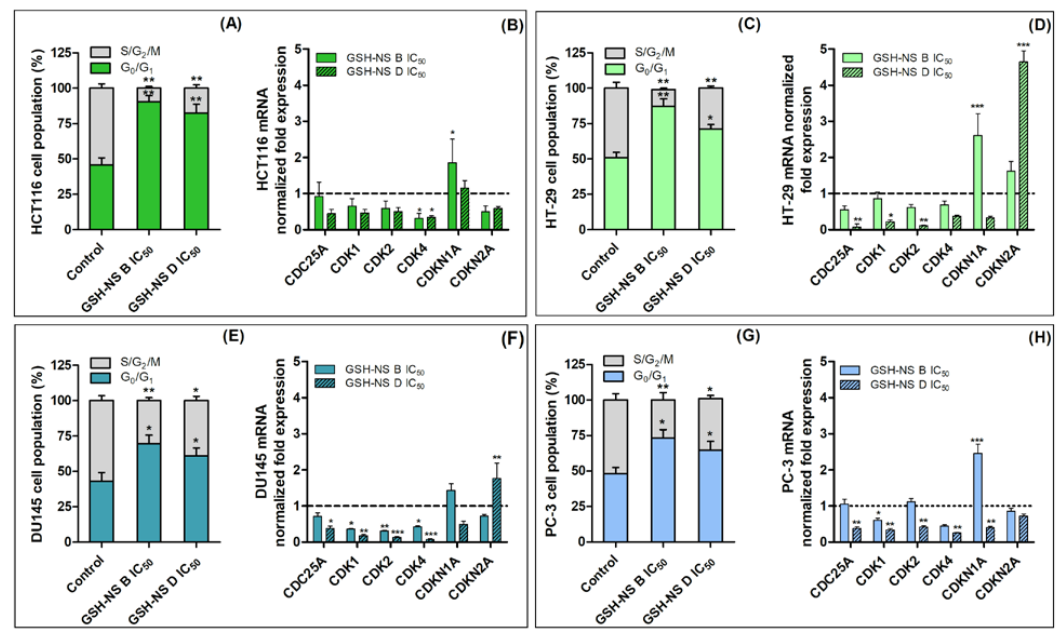
Figure 4. Glutathione responsive β -cyclodextrin-based nanosponge effect on cell cycle and mRNA expression. HCT116 ( A , B ), HT-29 ( C , D ), DU145 ( E , F ), and PC-3 ( G , H ) cells were exposed to the